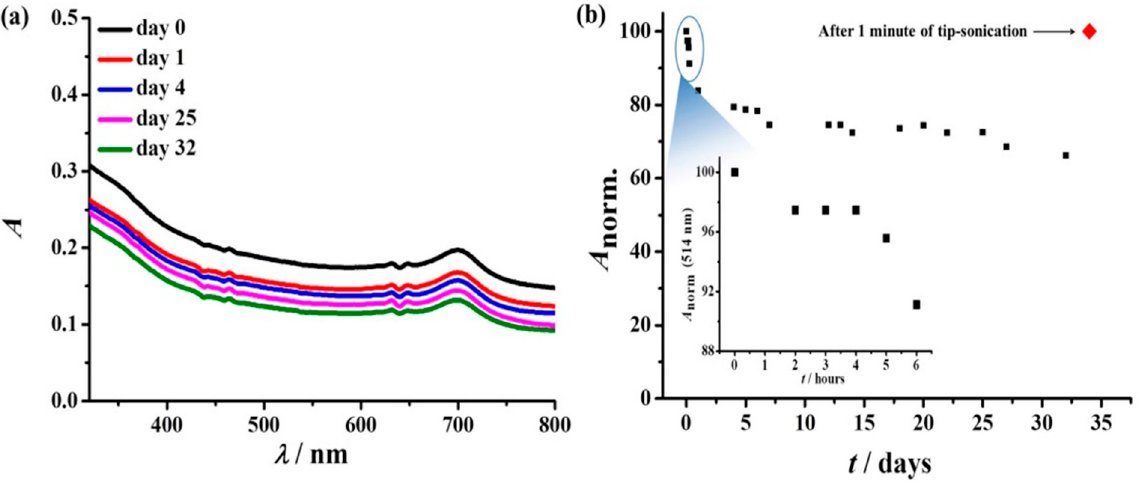
Figure 6. ( a ) A comparison of UV–Vis spectra recorded immediately after ink preparation ( day 0 ), and 1, 4, 25 and 32 days post-preparation (dilution: 100 × ); ( b ) the normalized view of the absorption at 514 nm (dilution: 100×); ( b ) inset sedimentation of the ink within the first six hours after ink preparation.